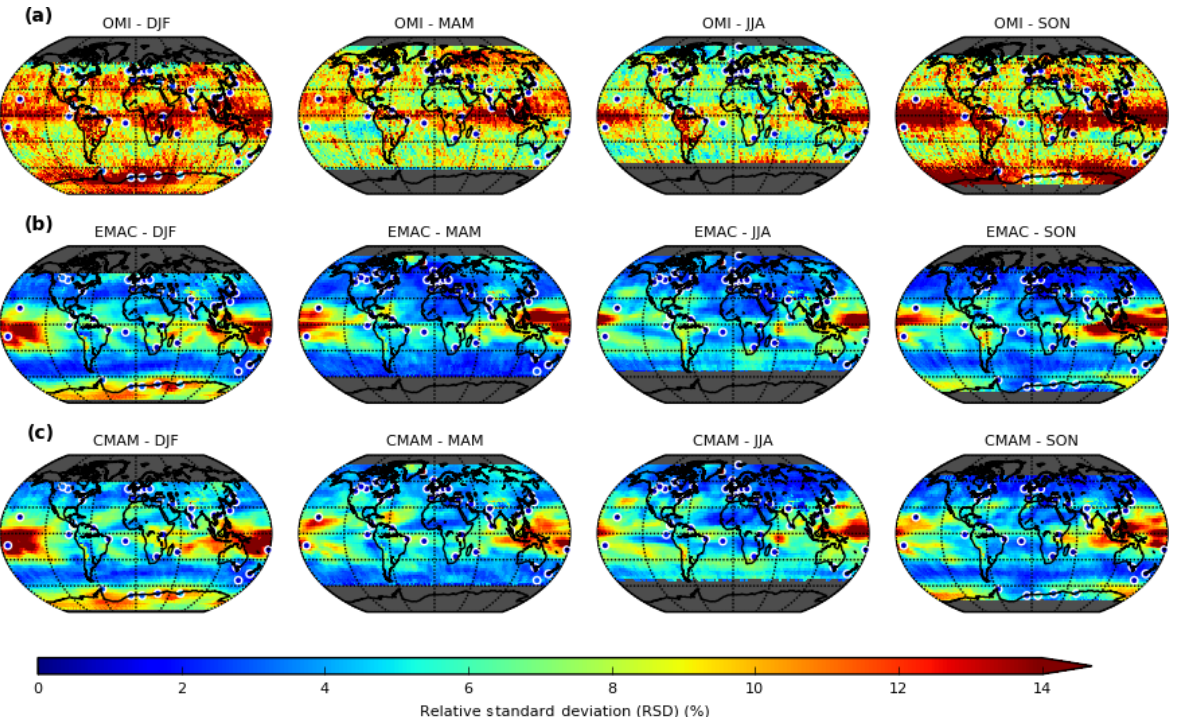
Figure 3. Seasonal composites (left to right) of monthly 1000–450hPa (0–5.5km) sub-column O 3 relative standard deviation (RSD) (%) for 2005–2010 for (a) OMI, (b) EMAC and (c) CMAM. Circles denote (a–c) the seasonal RSD calculated from ozone-sonde measurements. Model and ozone-sonde sub-column data have again been modified using AKs to ensure a direct comparison.